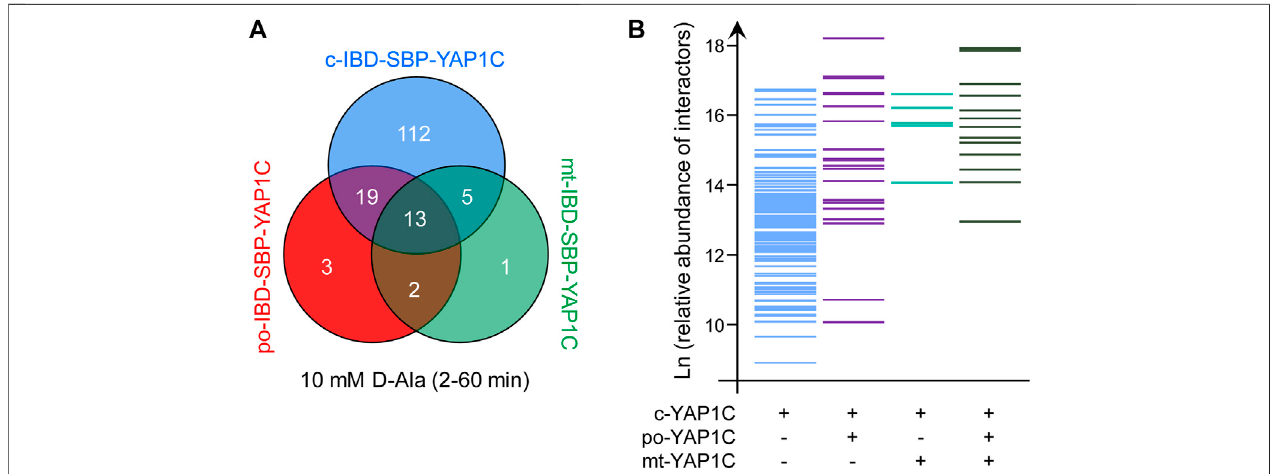
FIGURE 11 | Reproducibility and sensitivity ofthe IBD-SBP-YAP1C-interactor enrichment work fl ow. (A) Venn diagram showing the number and overlap of all po-, c-,andmt-IBD-SBP-YAP1CinteractorswithapredominantlycytosolicdistributionpatternaftertreatmentofFlp-InT-REx293cellsexpressingpo-DD-DAOwith10 mM D-Ala for 2, 5, 15, 30, and 60 min. Note that only the residual pools of po-IBD-SBP-YAP1C and mt-IBD-SBP-YAP1C that are not yet imported in peroxisomes and mitochondria,respectively,havethepotentialtotrapcytosolicallylocatedsulfenylatedproteins. (B) Barplotshowingtherelativeabundance(expressedasLn(x))of predominantly cytosolic c-(IBD-SBP-)YAP1C interactors that form disul fi de bridges or not with residual cytosolic po- and/or mt-(IBD-SBP-)YAP1C.